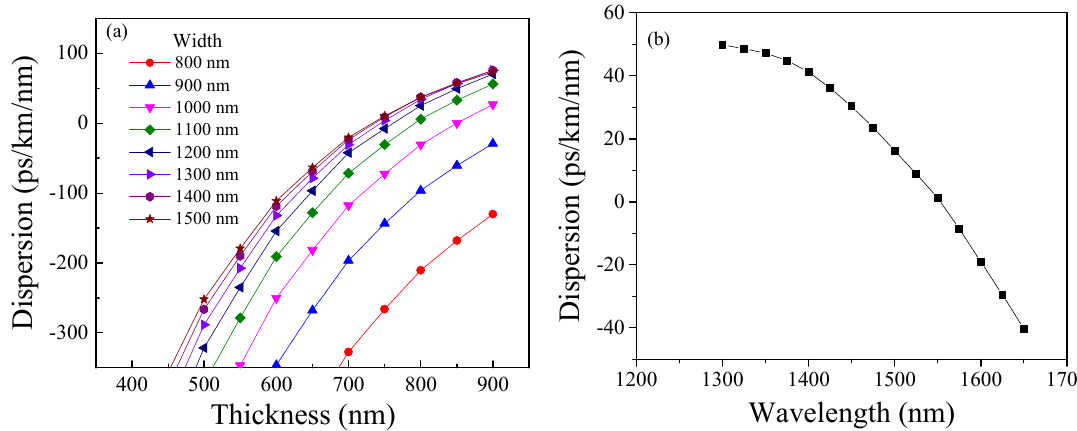
Figure 4. The dispersion of LPCVD silicon nitride waveguide ( a ) with different widths and thicknesses, and ( b ) with an optimized thickness of 790 nm and width of 1100 nm.